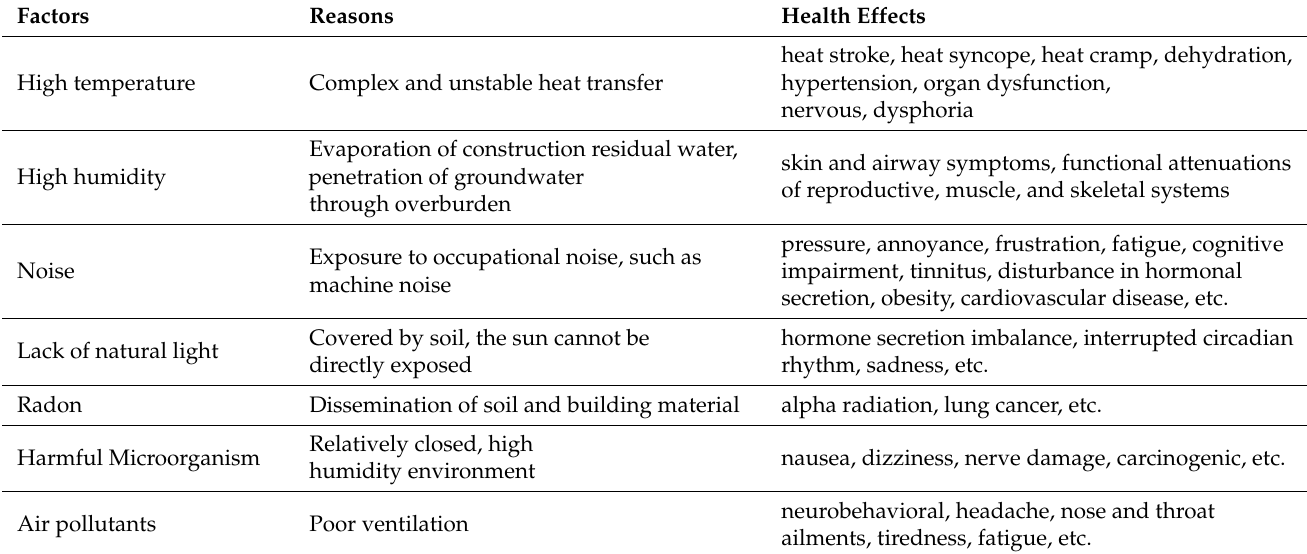
Table 2. Potential health effects and causes of underground space personnel